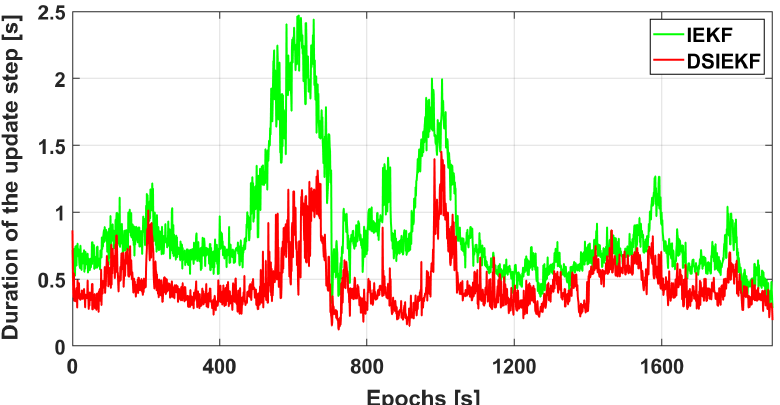
Figure 15. Duration of the update